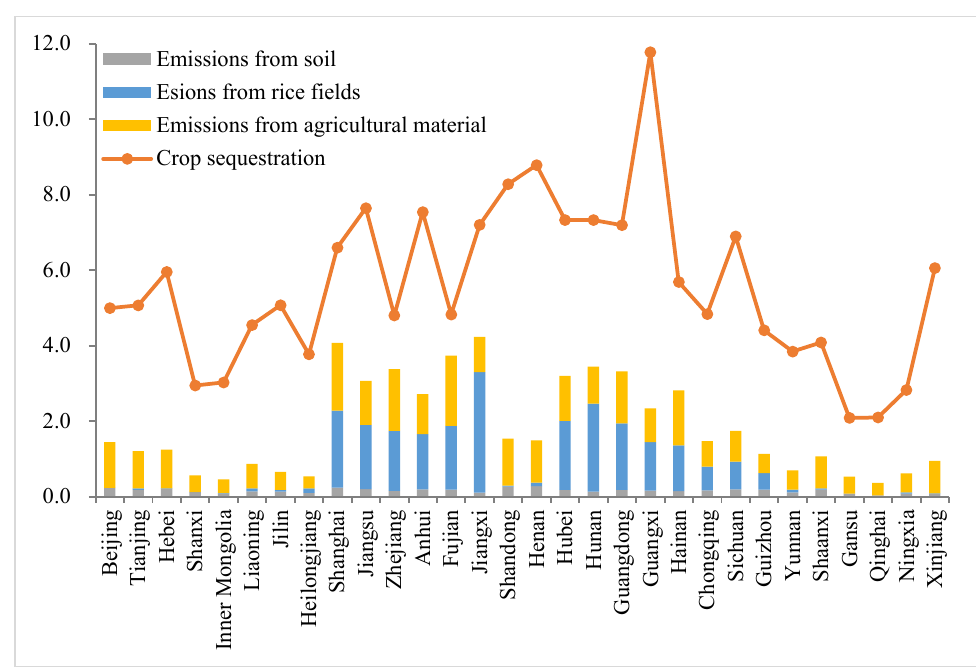
Figure 2. Agricultural carbon emissions and sequestration in China from 2000 to 2020 (t/hm 2 ).